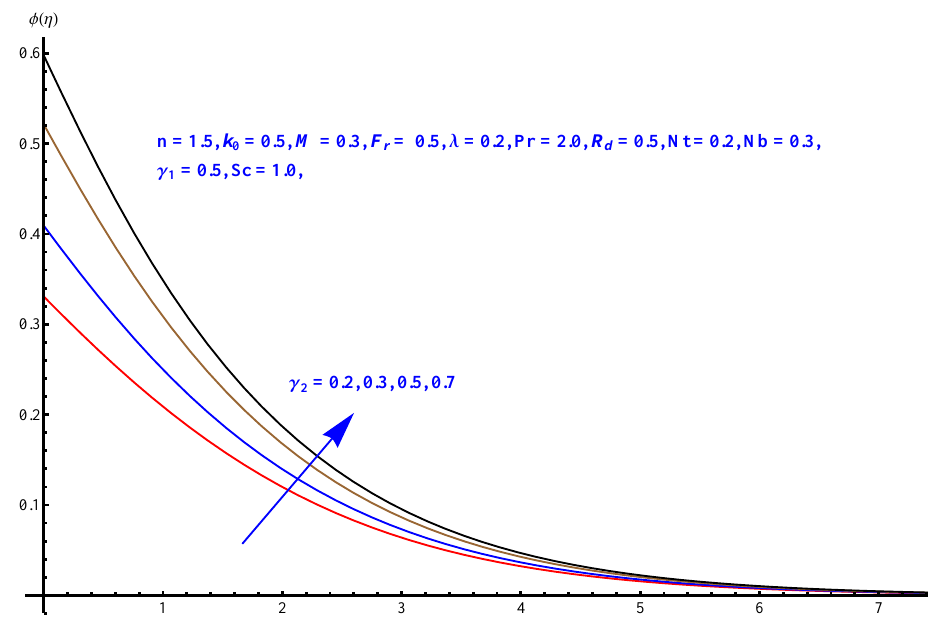
Figure 10. Solute Biot number versus concentration distribution.